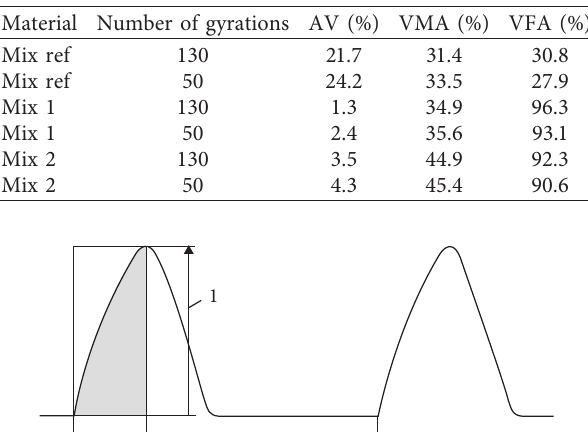
Table 1: Physical properties of aggregates (EN 1097-6/7).